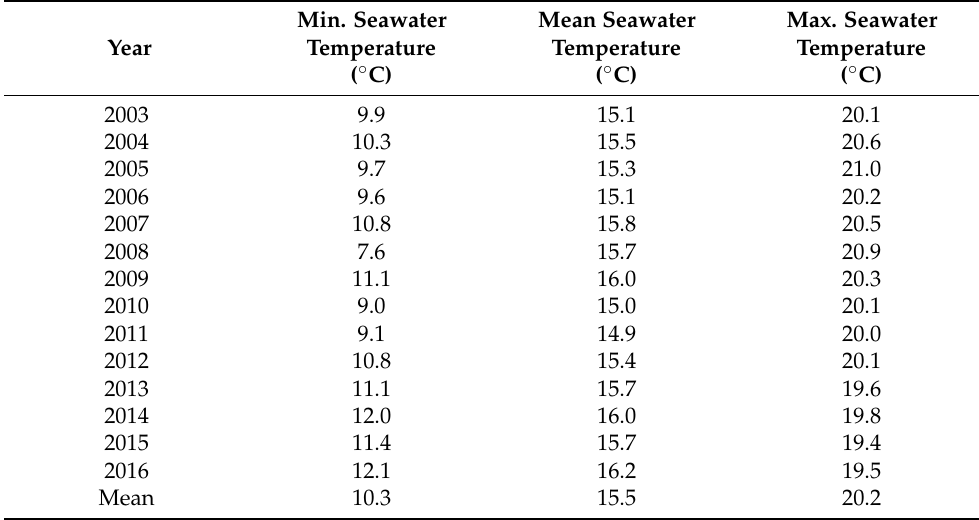
Table 2. Seawater temperatures and indicators by year from 2003 to 2016. Mean Min. Seawater Year ( ◦ C)